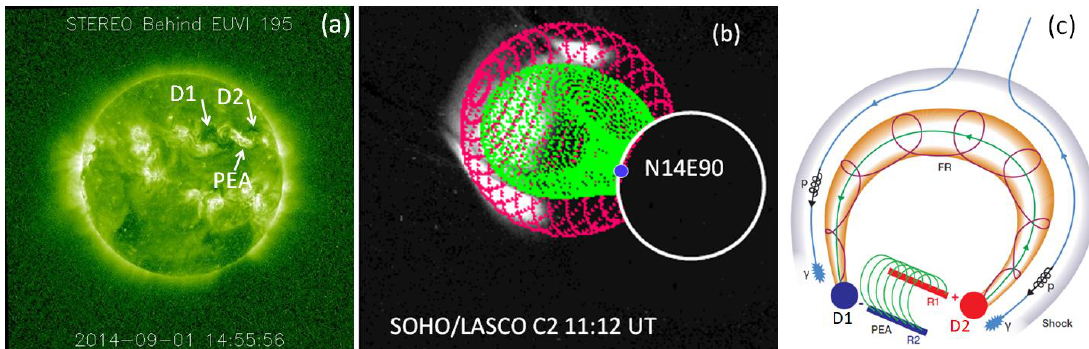
Figure 5. ( a ) An extreme ultraviolet image obtained by the STEREO mission showing the spatial structure of the eruption region consisting of dimming regions (D1, D2) and the post-eruption arcade (PEA). ( b ) A flux rope (green) and shock (red) structures superposed on a SOHO white-light image showing the CME. The blue dot (at heliographic coordinates N14E90) represents the centroid of the Fermi / LAT gamma-ray source located between the flux rope (FR) leg and the shock front. The flux rope legs are rooted in the dimming regions D1 and D2. ( c ) A schematic showing the FR and the surrounding shock. Particles accelerated near the shock nose travel along magnetic field lines in the space between the FR and shock, precipitate in the chromosphere / photosphere to produce gamma-rays via the pion-decay mechanisms discussed in the text (adapted from Gopalswamy et al. [40]).